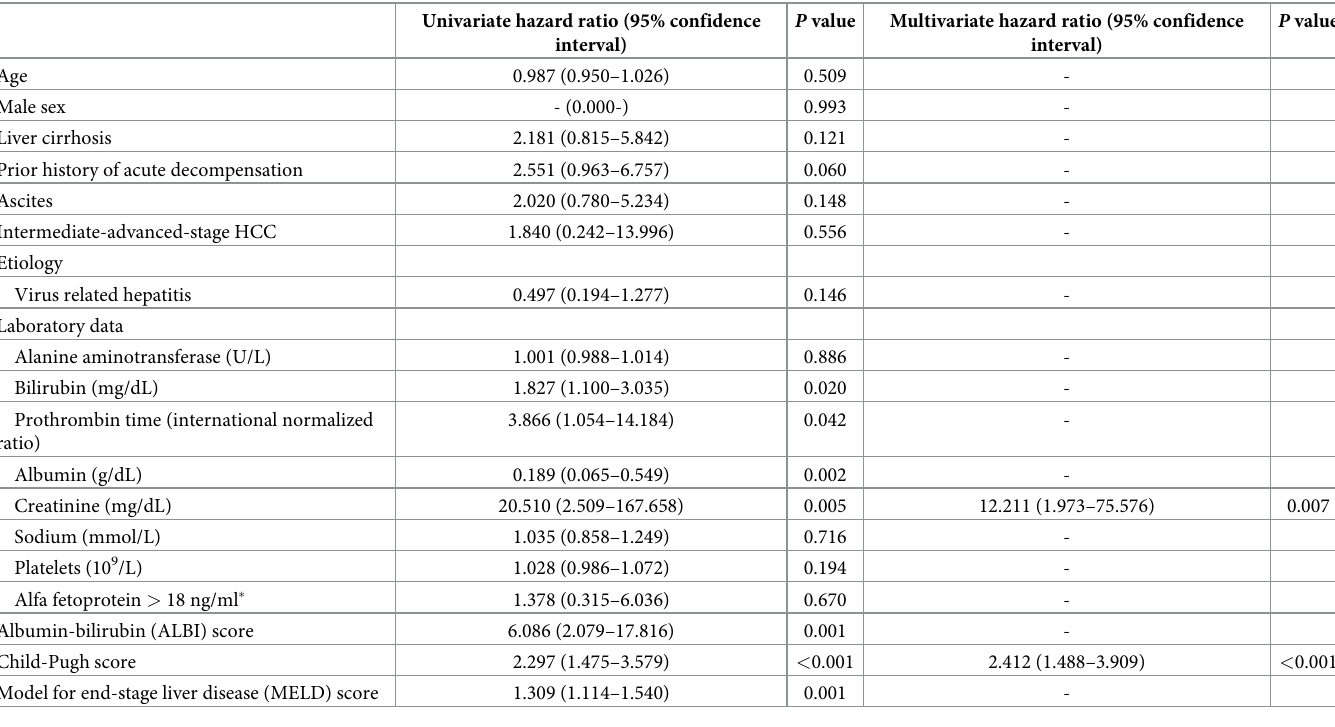
Table 6. Cox regression analyses of predictive factors for the development of acute decompensation in the systemic therapy